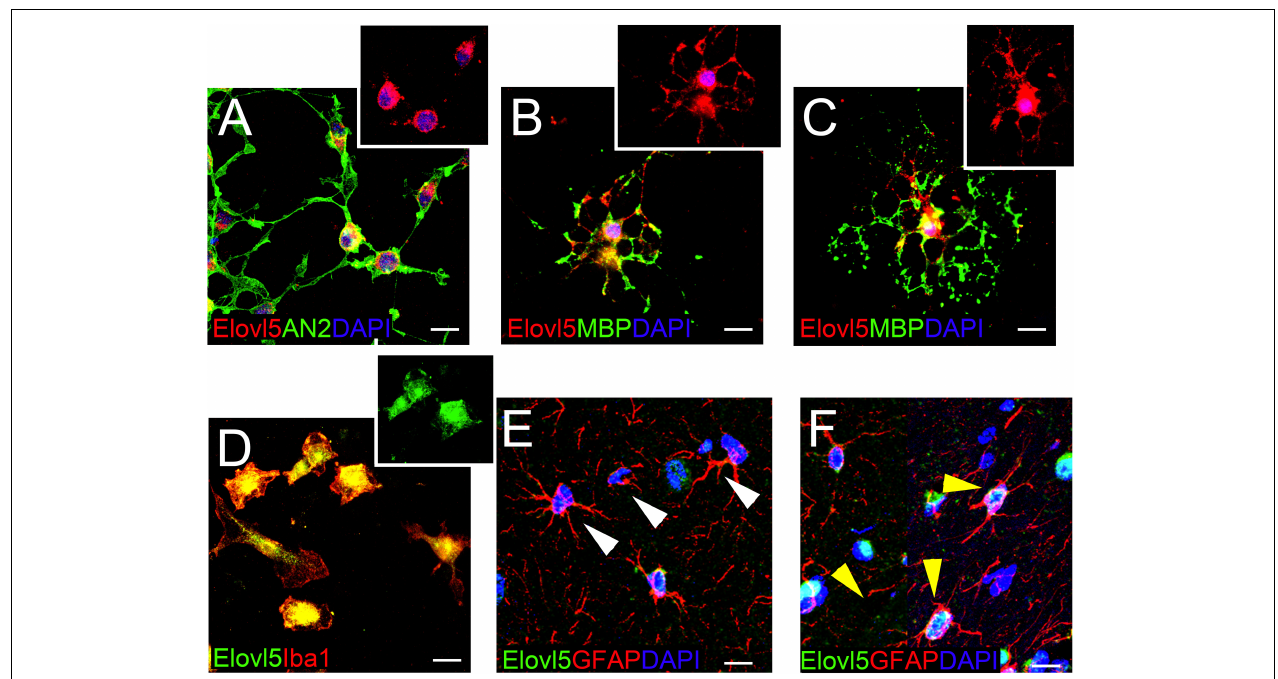
FIGURE 8 | Elovl5 expression in glial cells. (A–C) Widespread distribution of Elovl5 (red) in cultured AN2 + (green) oligodendrocyte precursor cells (A) and in maturing (B) and differentiated ramified (C) MBP + (green in B-C) oligodendrocytes. (D) Elovl5 (green) expression in cultured Iba1 + (red) microglia. (E,F) Sagittal brain slices showing low and heterogeneous expression of Elovl5 (green) in GFAP + (red) astrocytes. White arrowheads in (E) point to negative cells. Yellow arrowheads in (F) point to Elovl5 + cells. Scale bars: 10 µ m.